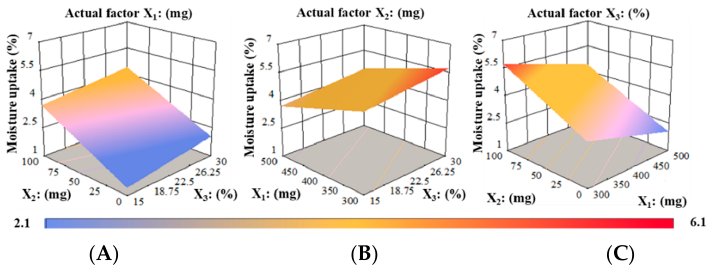
Figure 9. 3D surface models describing the influence of ( A ) PUL (X 1 ), ( B ) MTX (X 2 ), and ( C ) PG (X 3 ) on moisture absorption (Y 6 ) of RZT-ODFs. on moisture absorption (Y 6 ) of